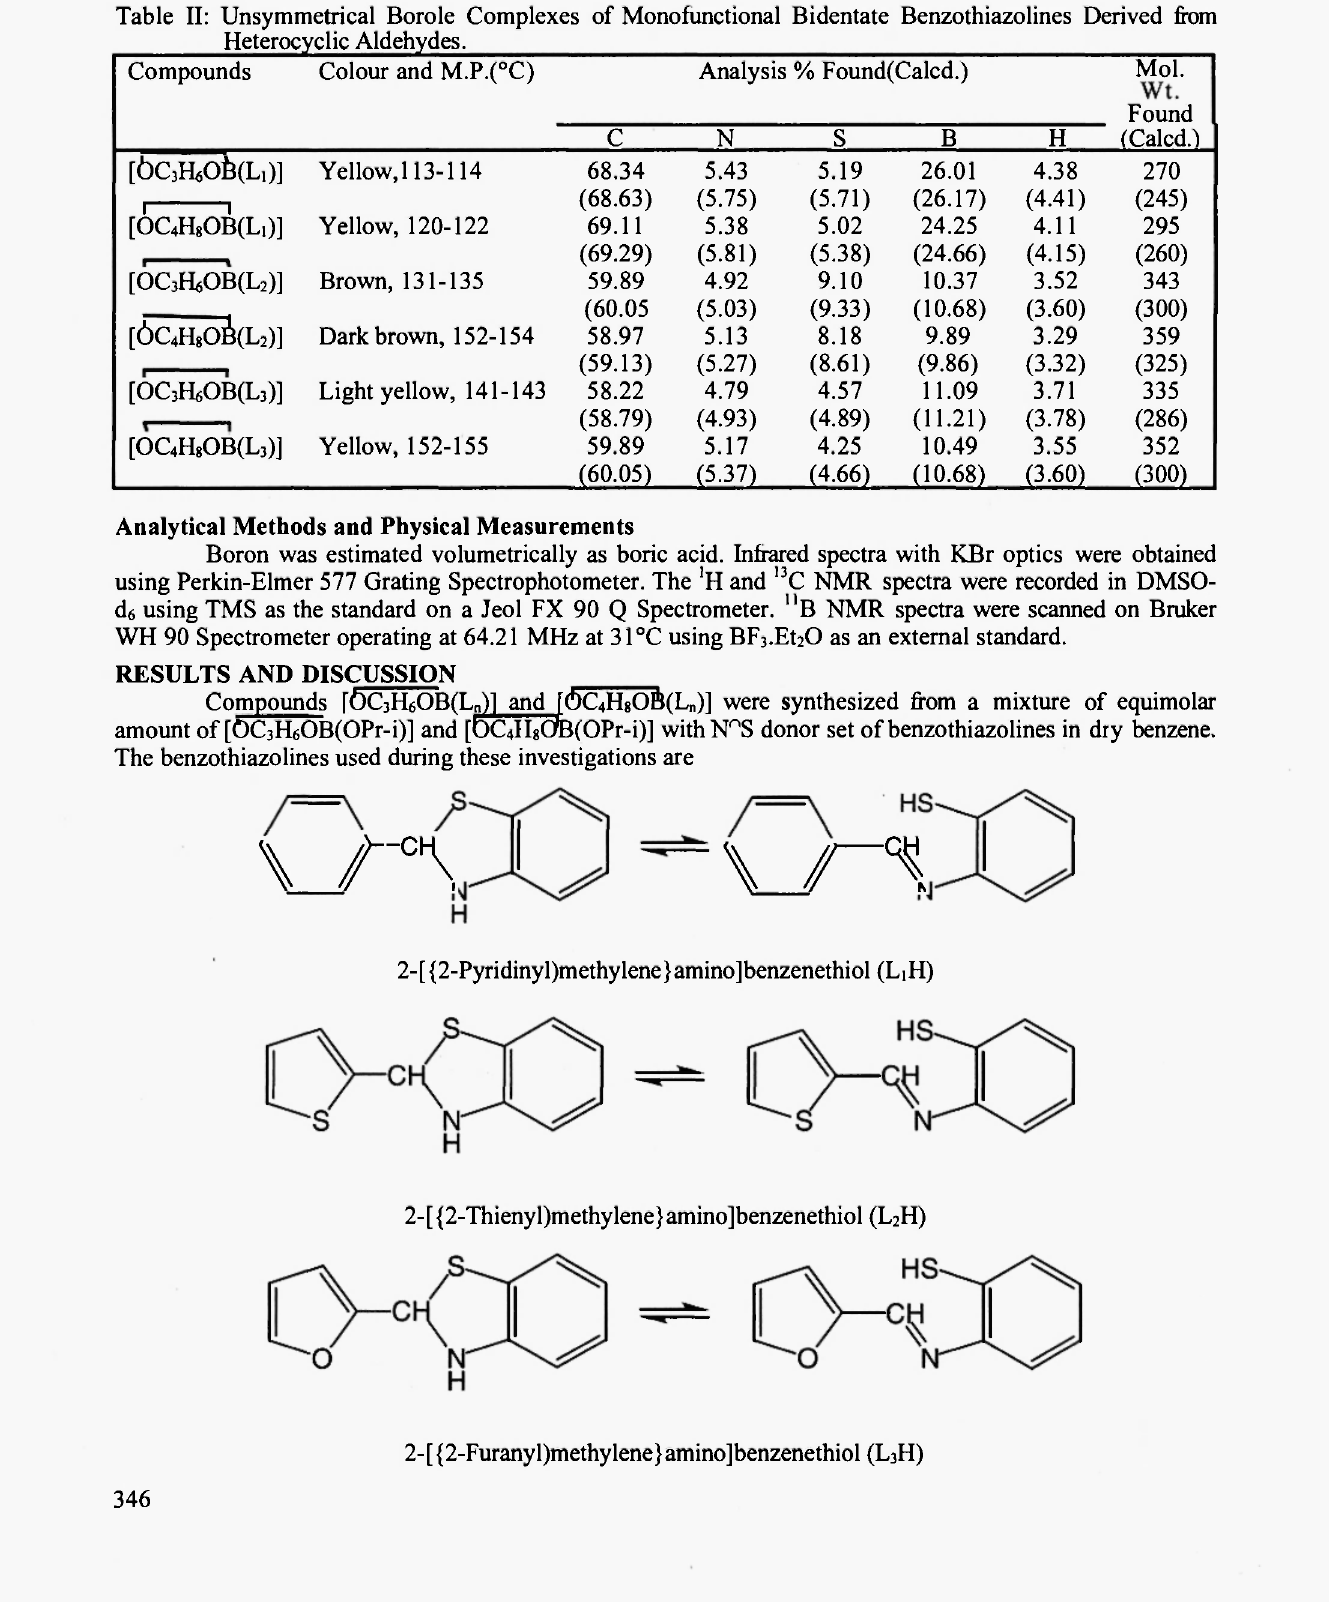
Table II: Unsymmetrical Borole Complexes of Monofunctional Bidentate Benzothiazolines Derived from Heterocyclic Aldehydes. Compounds Colour and M.P.(°C) Analysis % Found(Calcd.)